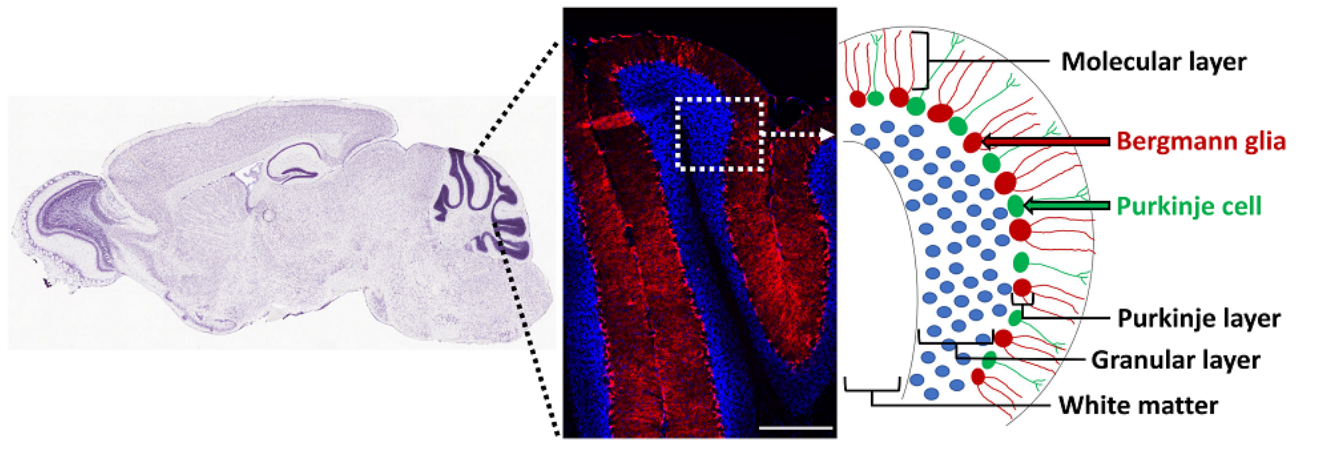
Figure 3. Bergmann glia in the adult cerebellum. Gli1-expressing Bergmann glia were fate-mapped by tamoxifen injection in the adult (P60-80) Gli1CreER;Ai9 mice and analyzed by immunofluorescence to detect TdT-positive (red) Gli1 fate-mapped cells and Hoechst (blue)-positive cell nuclei, 2 weeks after tamoxifen administration.